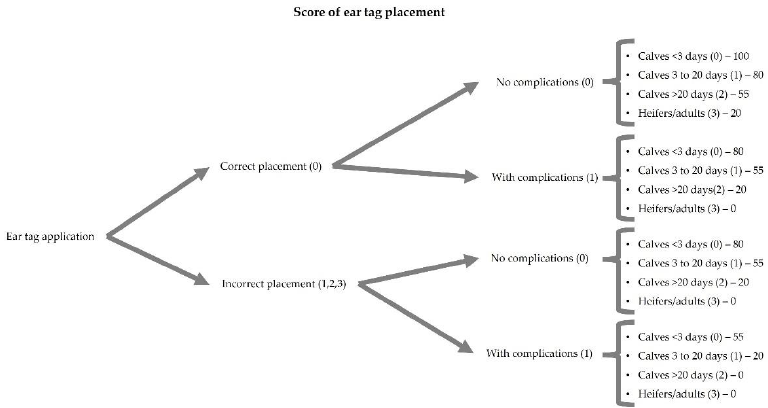
Figure A2. Decision tree for scoring ear tag placement.